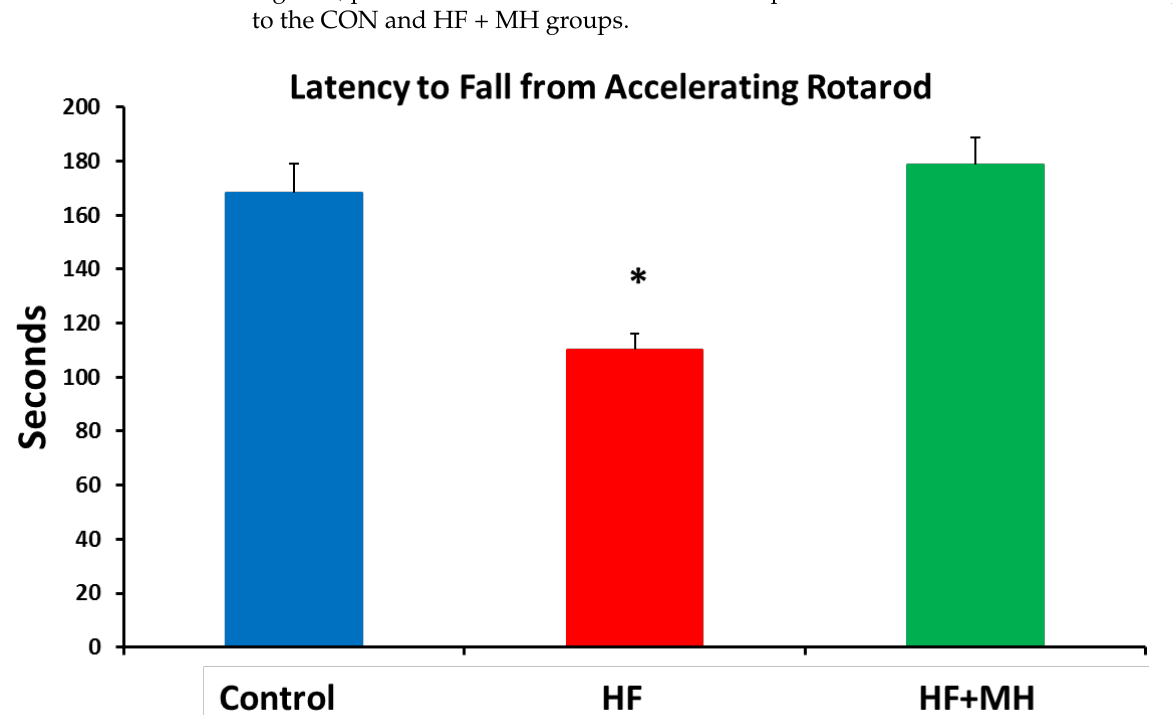
Figure 6. ( A ): Leptin levels measured in white adipose tissue after 9 months on diets (Ns = 6 – 8). ( B ): Adiponectin levels in white adipose tissue after 9 months on diets (Ns = 6 – 8).